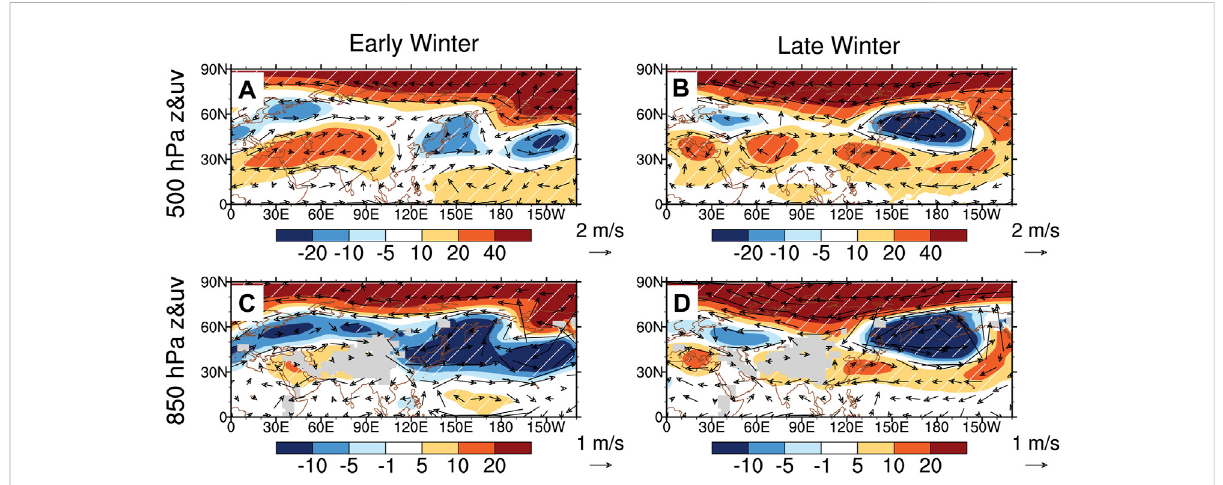
FIGURE 12 Differenceingeopotentialheight(contours;units:gpm)andwind fi eld(vectors;units:m/s)betweenP2andP1in (A,C) earlywinterand (B,D) late winter at 500 hPa and 850 hPa based on the r1i1p1f1 ensemble member in FGOALS-F3-L model. The white slanted lines represent p < 0.05.